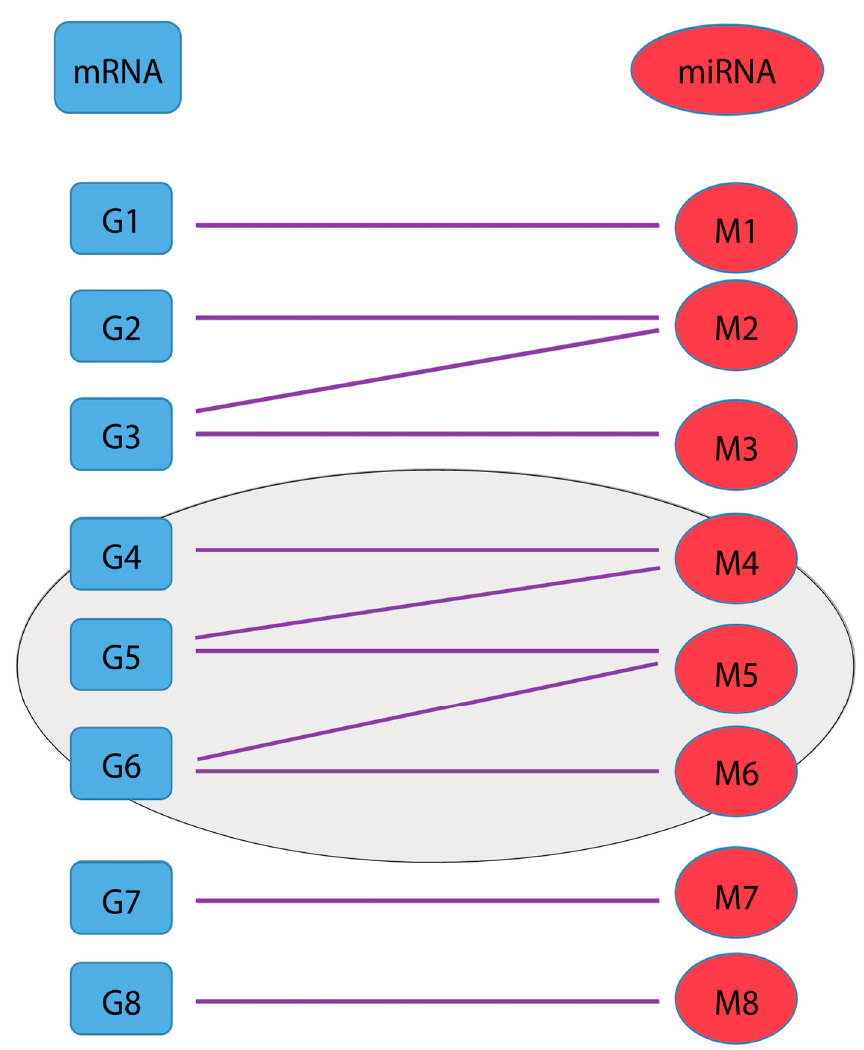
Figure 1. Bipartite diagram for messenger RNA (mRNA) (blue, left) and microRNA (miRNA) (red, right) interaction pairs, with a cluster identified by a purple ellipse.